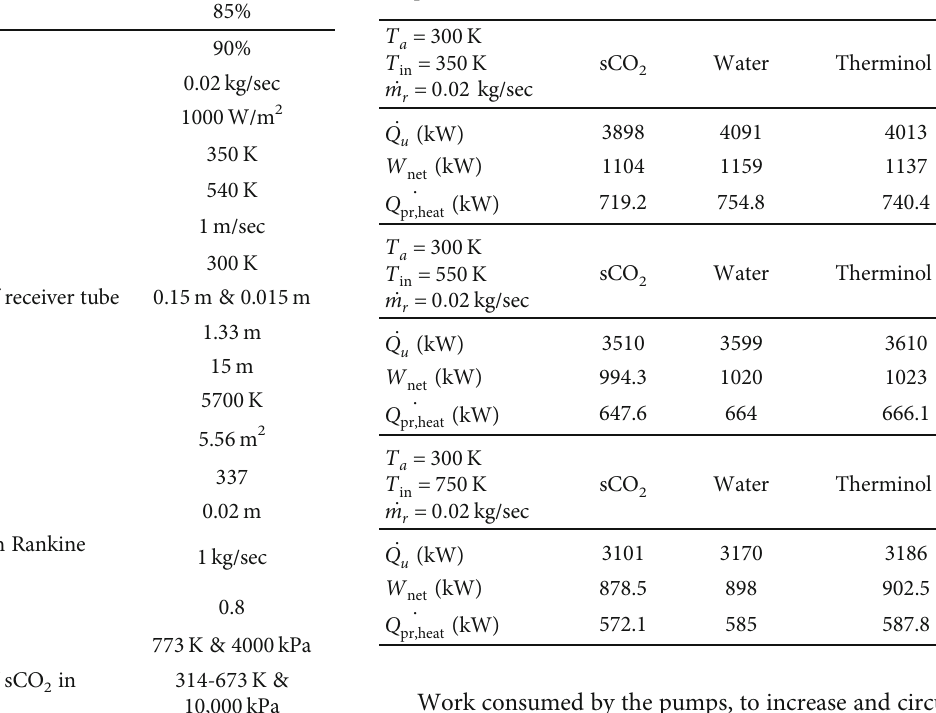
Table 1: Investigated system characteristics [41, 42]. Table 2: Comparison table for three HTFs at three inlet temperature